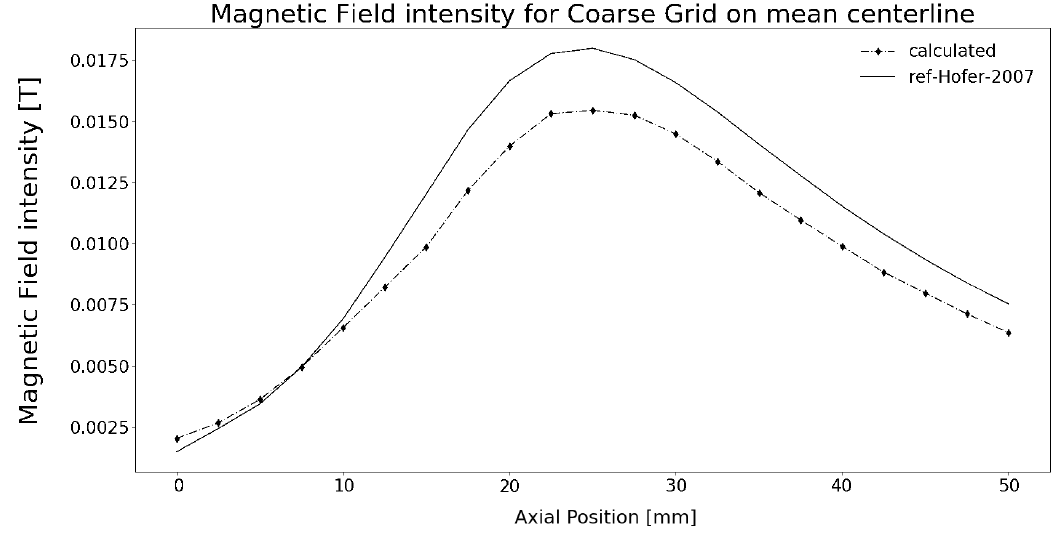
Figure 8. SPT-100: magnetic field intensity calculated by FEMM and interpolated on the PIC grid (25 × 7). Dash-dot red line denotes channel exit whereas the continuous red line indicates the channel centreline.